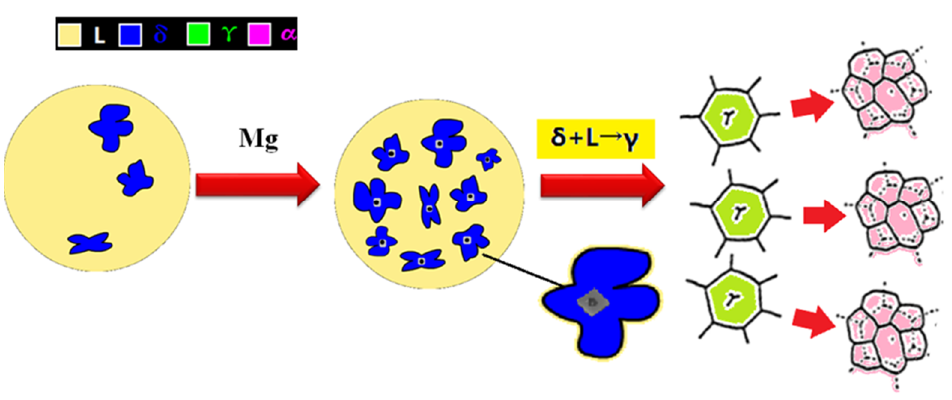
Figure 15. Mechanism of grain size improvement of peritectic steel as a result of magnesium treatment.